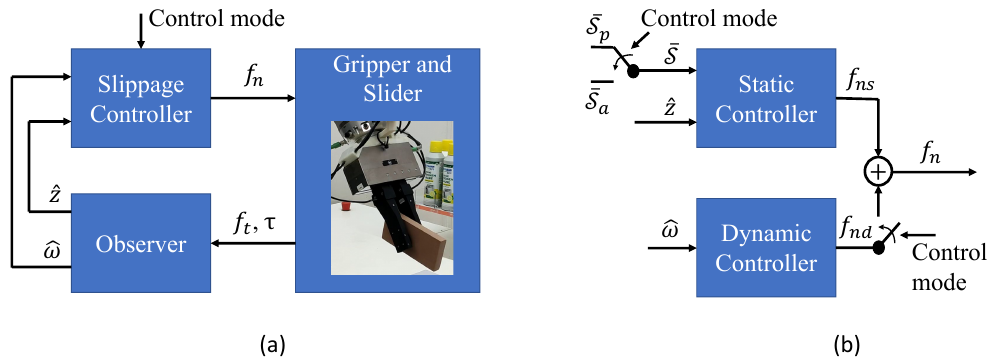
Figure 6. Control scheme: ( a ) closed loop system with the interconnections; ( b ) details of the slippage controller. The control mode can be either slipping avoidance or